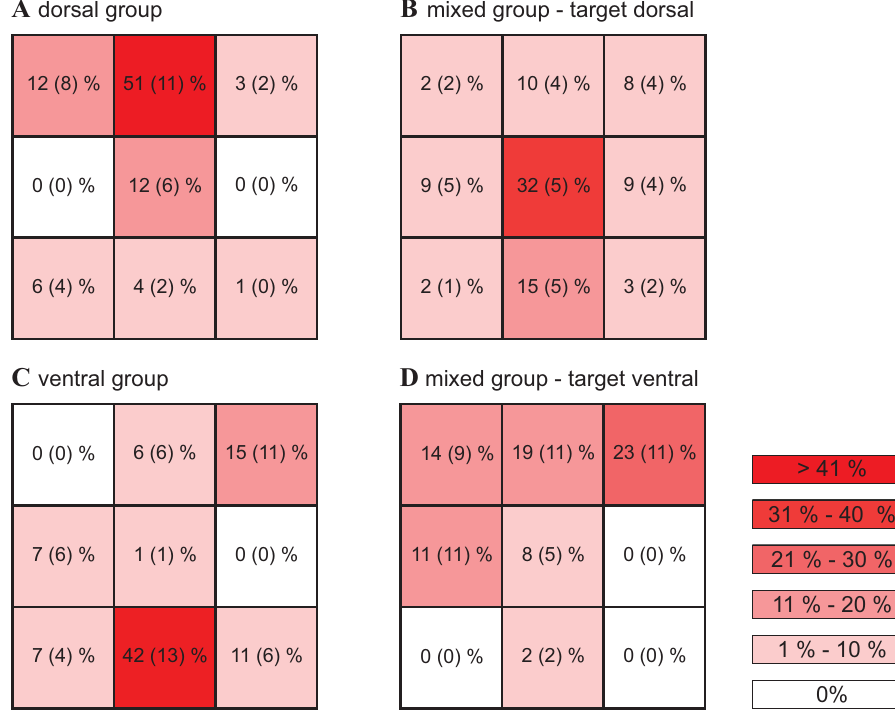
Figure 7. Positions of bees when making errors. A decision error occurs when the bee steers towards a distractor or an empty position (here shown for a distance of 5 cm from the search screen). ( A–D ) Error frequency for the different locations (3 rows x 3 columns) for all experimental groups (colour code see explanation on right). The numbers give the mean percentages (+/- s.e.m.) of false decisions at the respective position. N=9 bees per